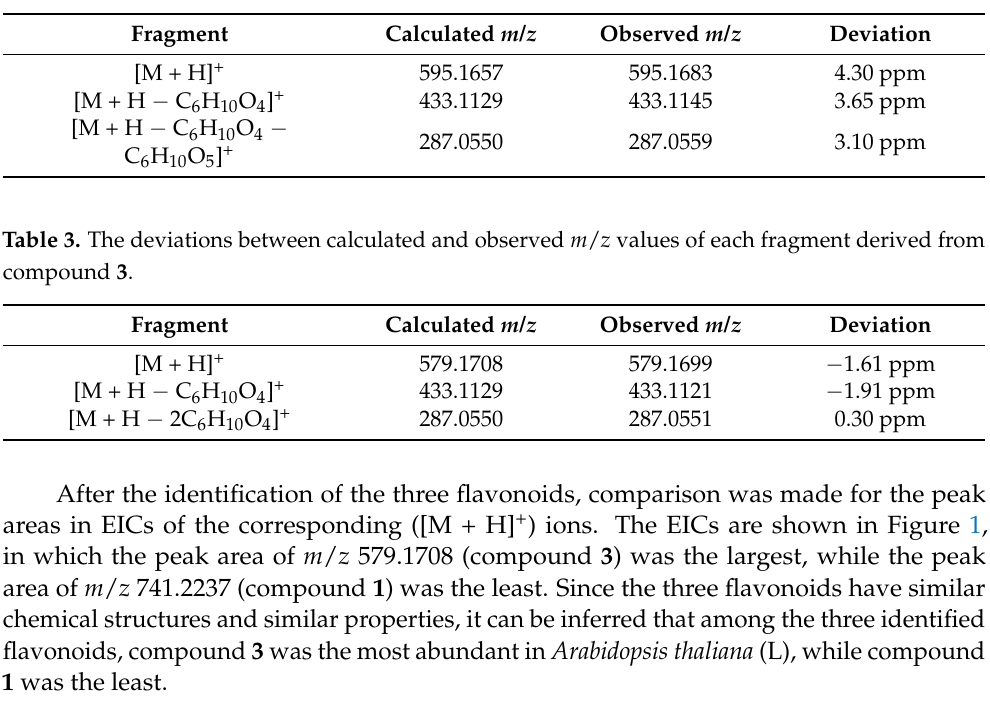
Table 2. The deviations between calculated and observed m / z values of each fragment derived from compound 2 .